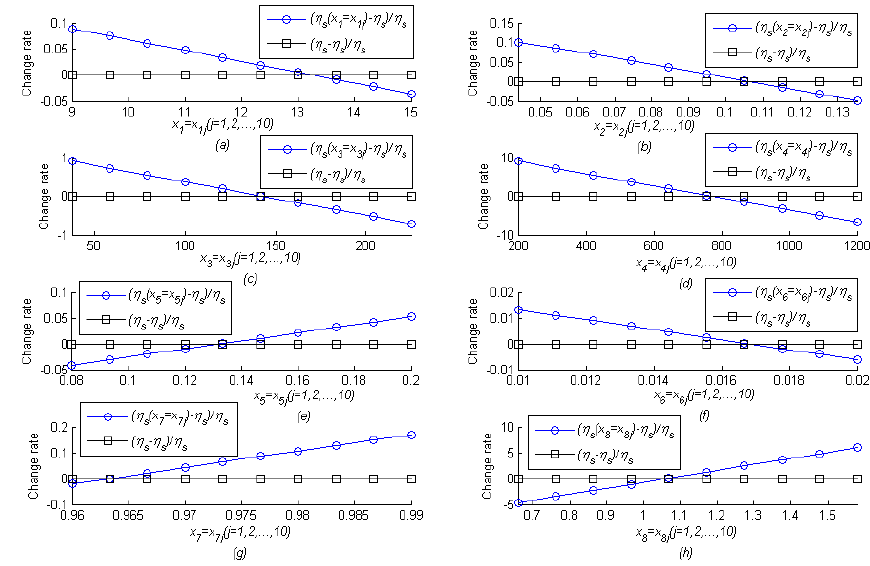
(cid:16) (cid:17) − η s η s | x / η s ( j = 1,2,. . .,10 ) , i = x ij